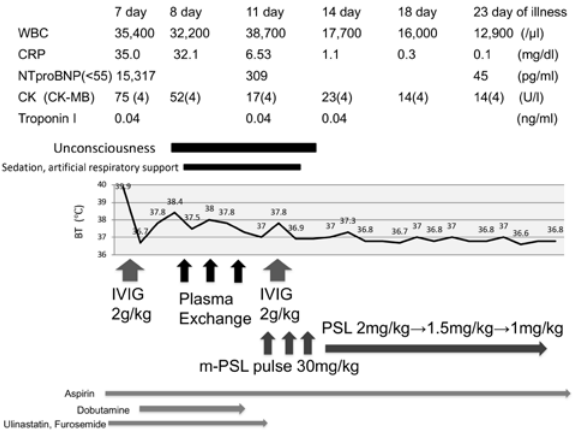
Figure 3: Clinical course Treatments with IVIG (2 g/kg), aspirin (30 mg/kg/day), ulinastatin (5000 units/kg/dose, four times a day), and furosemide (1 mg/kg/ dose, three times a day) were started on day 7 of illness. A